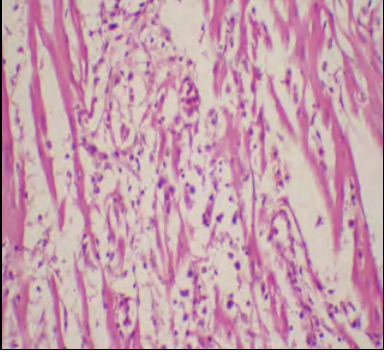
Figure-6. Spleen: Showing secondary follicles and multiple necrotic areas ( Salmonella Gallinarum infection) H & E x 33